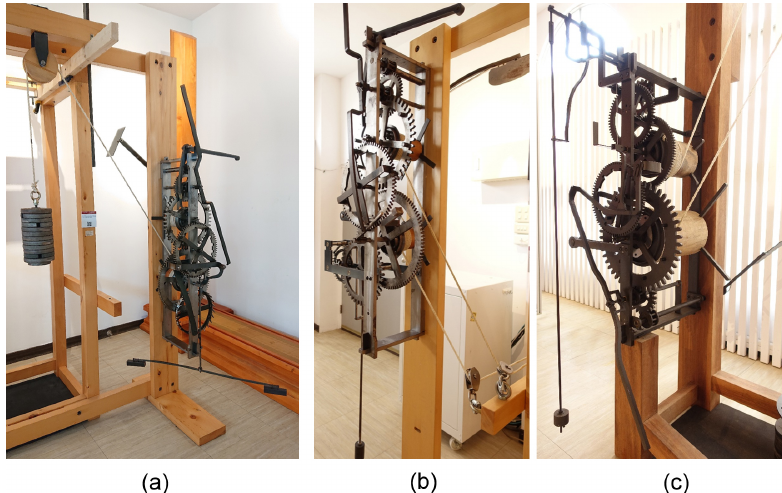
Figure 14. Restoration design: (a) Cotehele clock, (b) Marston Magna clock, and (c) Castle Combe clock (photo by Wen-Feng Lin).